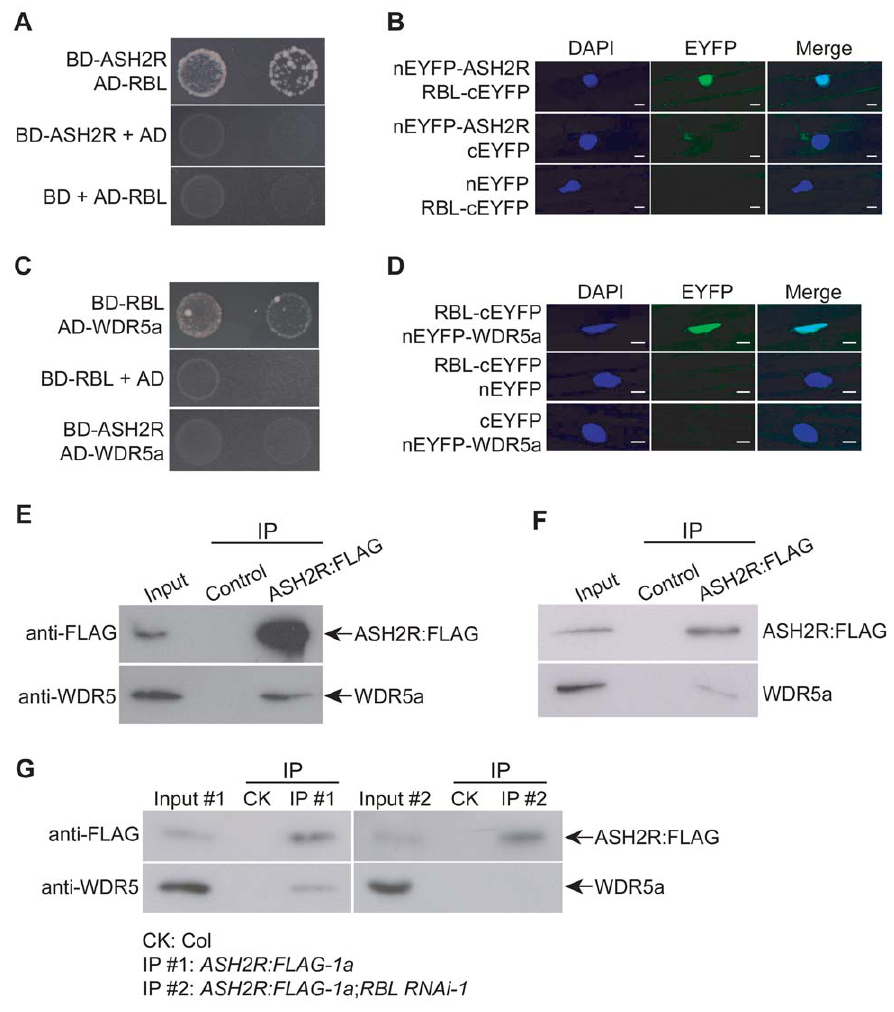
Figure 7. ASH2R, RBL, and WDR5a Form a Nuclear Complex during Vegetative and Reproductive Development. (A) Interaction of ASH2R with RBL in yeast. Full-length ASH2R and RBL proteins were respectively fused with the GAL4 DNA-binding domain (BD) and activation domain (AD). Yeast cells harboring these fusions, AD and/or BD, as indicated, were grown on the highly selective SD media lacking of Trp, Leu, His and adenine. (B) BiFC assay of nEYFP-ASH2R and RBL-cEYFP in onion epidermal cells. Plasmid pairs as indicated, were used to transiently co-transform onion epidermal cells by biolistic gene bombardment. Yellowish-green signal indicates the binding of nEYFP-ASH2R with RBL-cEYFP in the nuclei. Blue fluorescence from DAPI (4 9 ,6-diamidino-2-phenylindole) staining indicates nuclei. Fluorescence signals were imaged using a laser scanning confocal microscope. Bar = 20 m m. (C) Interaction of WDR5a with RBL in yeast. Full-length WDR5a and RBL proteins were fused with the GAL4 BD and AD domains, respectively. (D) Physical interaction of WDR5a with RBL in onion epidermal cells as analyzed by BiFC. Bar = 20 m m. (E) Co- immunoprecipitation of ASH2R with WDR5a in 10-d-old seedlings. Total protein extracts from Col (WT; as a negative control) and ASH2R:FLAG-1a (T 3 ) seedlings were immunoprecipitated with anti-FLAG agarose, and subsequently, the precipitates were analyzed by western blotting with anti-FLAG and anti-WDR5. The input was the ASH2R:FLAG-1a protein extract. (F) Co-immunoprecipitation of ASH2R with WDR5a in 5-DAP ASH2R:FLAG-1a siliques (T 3 ). The input was the ASH2R:FLAG-1a protein extract from siliques. (G) Co-immunoprecipitation analysis of ASH2R with WDR5a upon RBL knockdown. Total protein extracts from the seedlings of Col (as a negative control), hemizygous ASH2R:FLAG-1a (from the crossing of ASH2R:FLAG-1a to Col), and doubly hemizygous RBL RNAi-1;ASH2R:FLAG-1a were immunoprecipitated with anti-FLAG agarose. Input # 1 and Input # 2 were the protein extracts of ASH2R:FLAG-1a and RBL RNAi-1;ASH2R:FLAG-1a ,